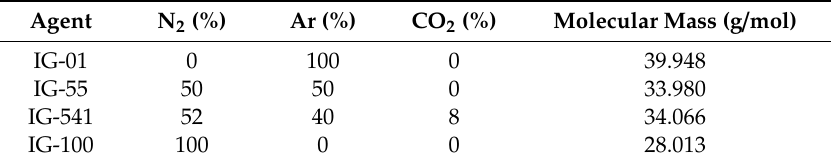
Table 1. Type and material characteristics of inert